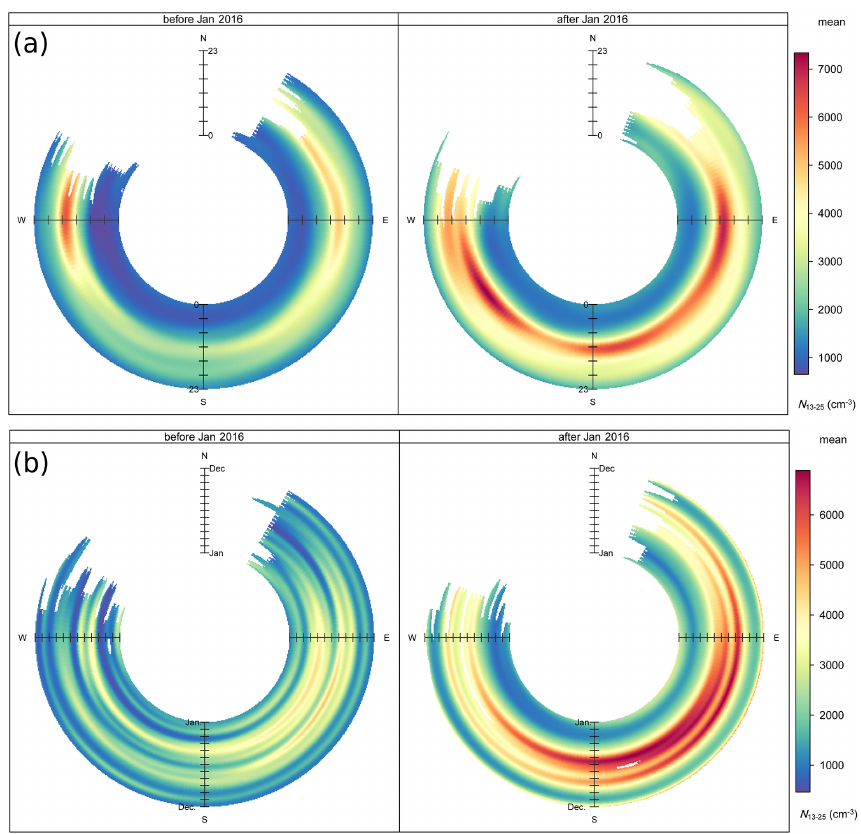
Figure 3. Mean diurnal (a) and annual (b) variations of particle number in 13–25 size bins ( N 13 − 25 ) as wind directions in the two contrasting periods (before vs. after January